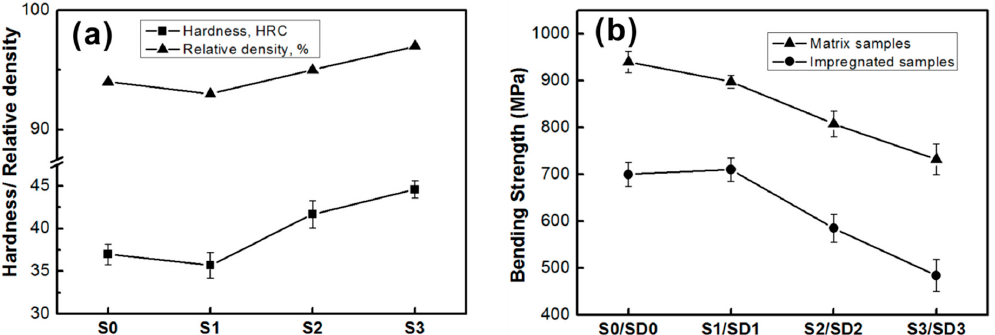
Figure 6. Mechanical properties of samples. ( a ) The relative density and HRC values of the matrix sample; ( b ) Bending strength of samples with and without impregnated diamond